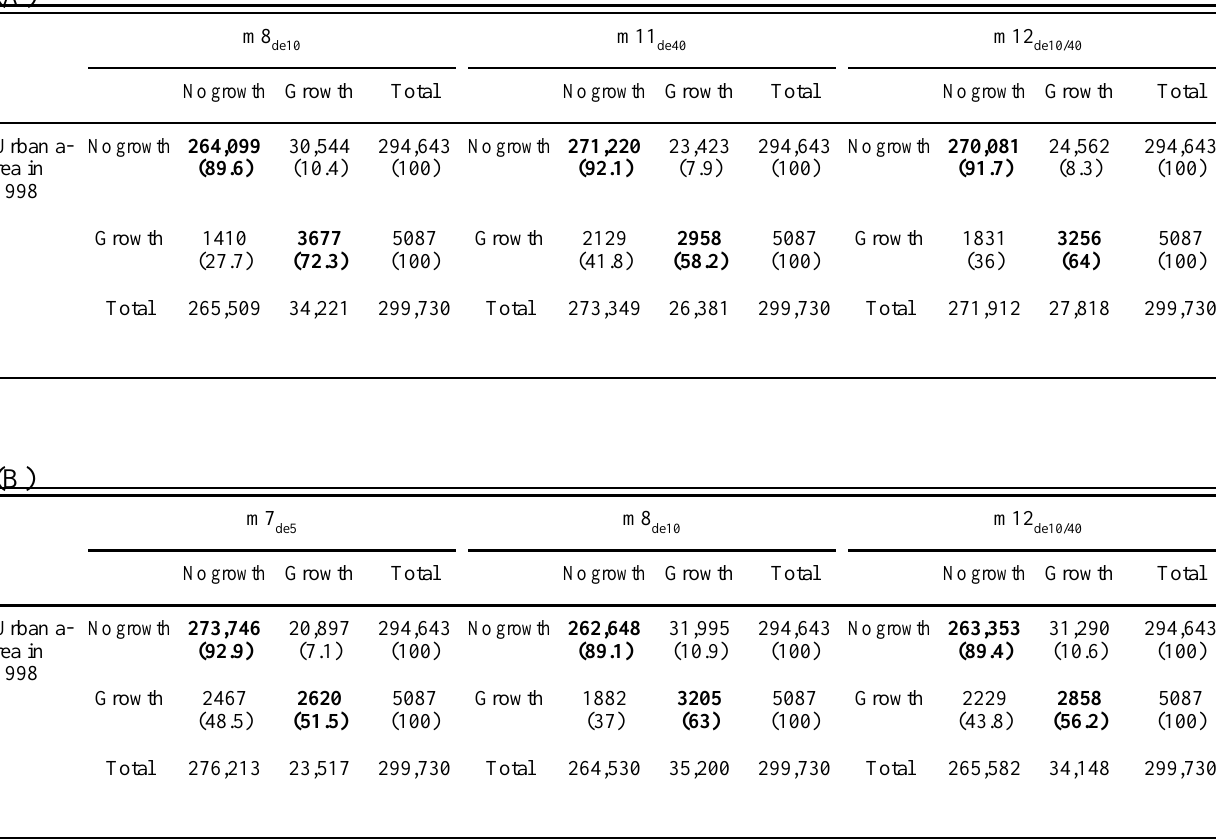
Table 5. Transition matrices evaluating the predictions of the best models using the (A) 3000-m and (B) 500-m growth surface by the number of cells correctly classified as having growth or no growth in urban area. Correctly classified cells are in boldface, incorrecly classified cells are in normal type, and numbers in parentheses indicate percentage of